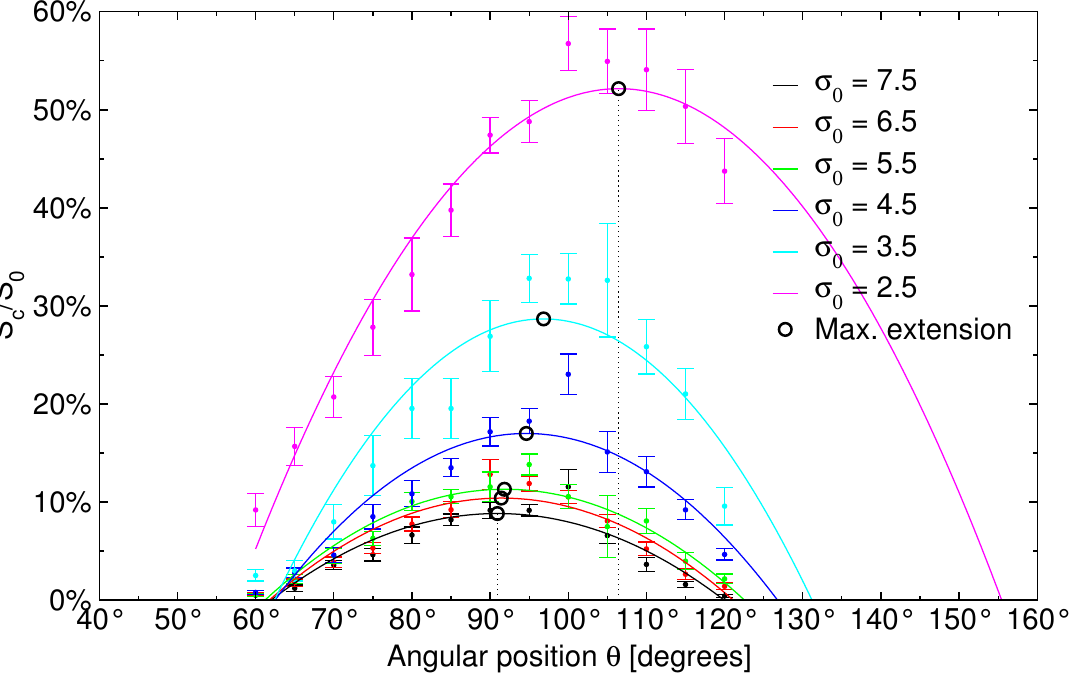
Figure 6. Cavity extension and corresponding root-mean-square fluctuations as a function of the propeller angle θ , for σ 0 ∈ [ 2.5,7.5 ] . The continuous lines are quadratic fit curves to the respective experimental data. The black circles indicate the location of the cavity maximum extension determined from the fit function.